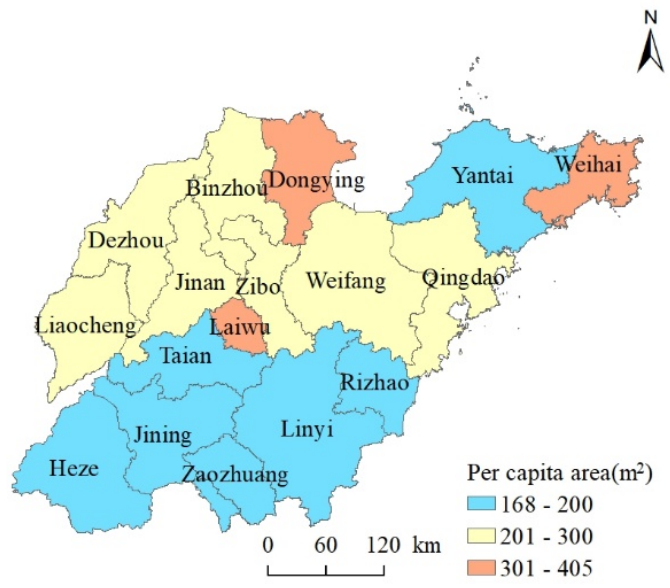
Figure 6. Spatial distribution of per capita rural settlement area in 2018. Using the rural population and rural settlement data of 136 counties in 2009 and 2018, the Thiel index was calculated to determine the degree of spatial matching between the rural population and rural settlement area. These results showed a high spatial matching degree, with small regional differences, and no excessive concentration or uneven distribu- tion. In addition, any regional differences were dominated by inter-regional differences. Specifically, the Thiel index in Shandong Province as a whole was small, but it showed a trend of increasing over time, rising from 0.12 in 2009 to 0.14 in 2018 (Table 1). The total Thiel index can be further decomposed into intragroup and intergroup differences; these both increased from 2009 to 2018. However, the contribution from the intragroup difference tended to increase over time, whereas that from the intergroup difference showed a de- creasing trend; however, the former predominated and was the main source of the overall difference found, accounting for 88% of the T value. The intergroup difference reflects the difference among average levels of the spatial matching degree between the rural population and rural settlement area among cities, while the intragroup difference refers to the difference in those levels of districts and counties within the same city. Compared with those among cities, the differences in natural conditions, social and economic development level, and related policies are often smaller within the same city, and the production and life styles of its farmers are more similar. Therefore, the differences in the spatial matching degree between the rural population and rural settlement between districts and counties within a given city are relatively small and more consistent than among cities. Table 1. The results for the Theil